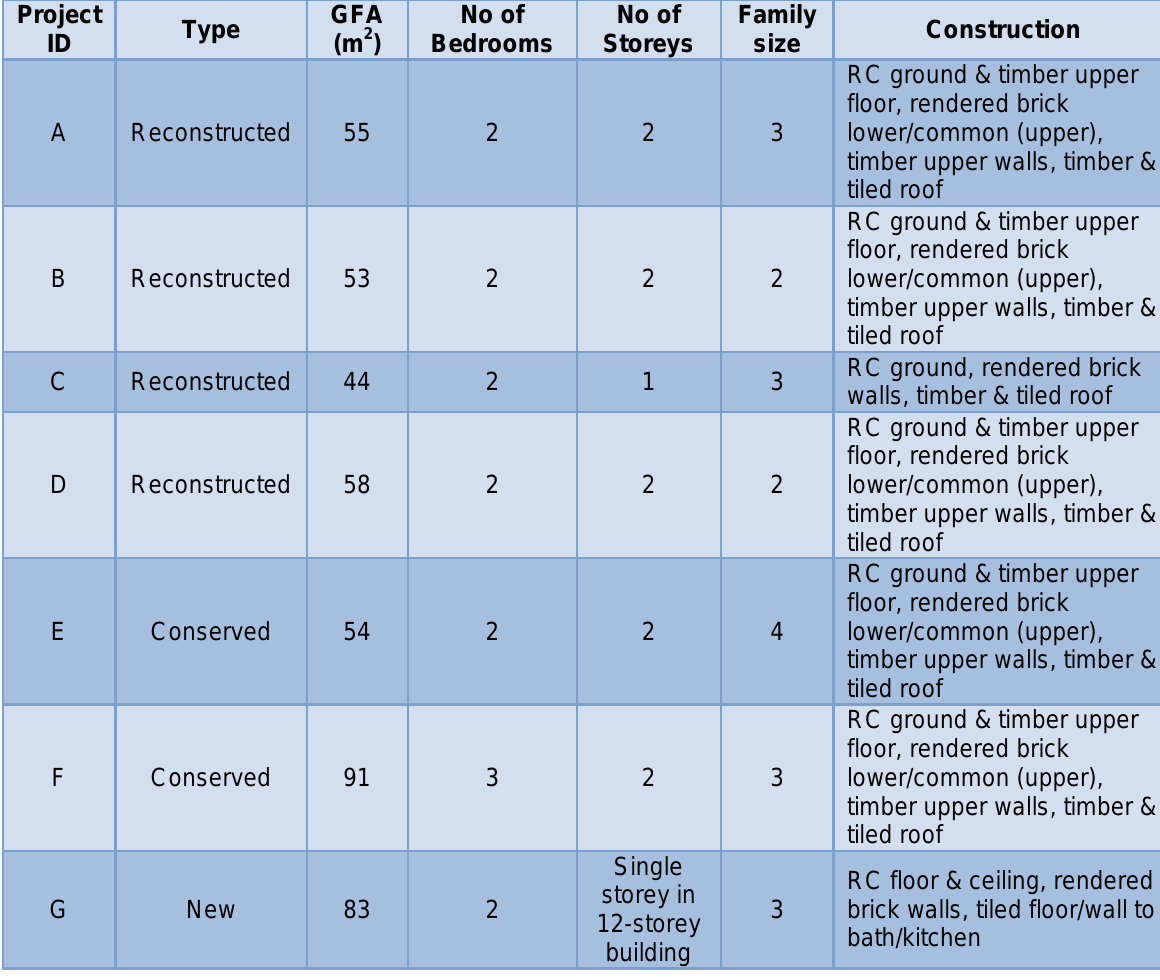
Table 1 Summary of details for the